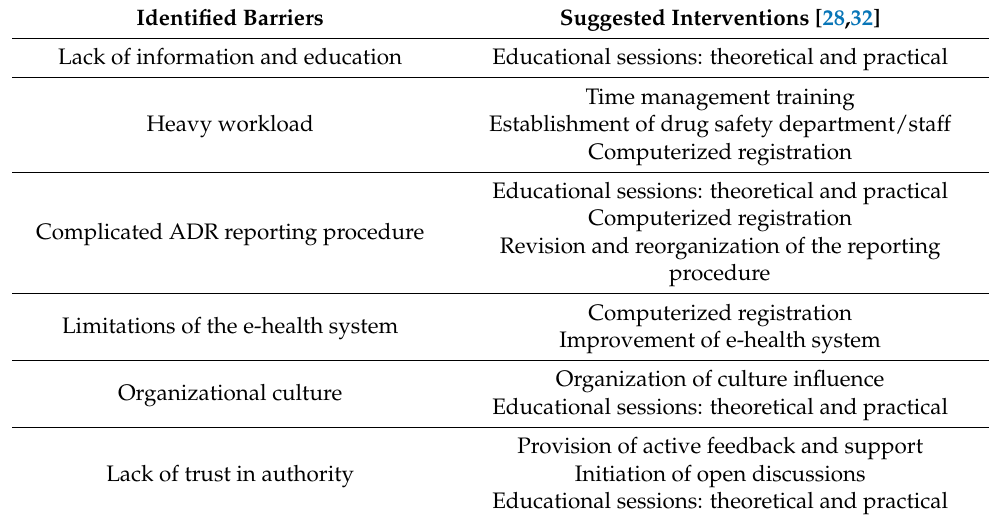
Table 3. Identified barriers and suggested